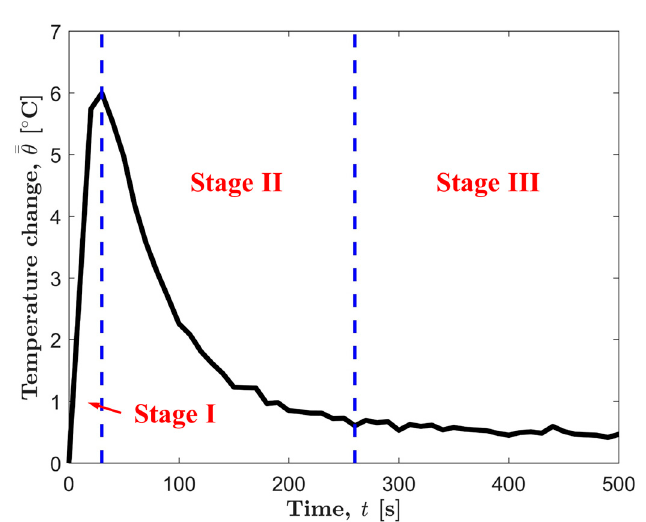
Figure 6. Typical temperature evolution curve processed by the superposition filter.